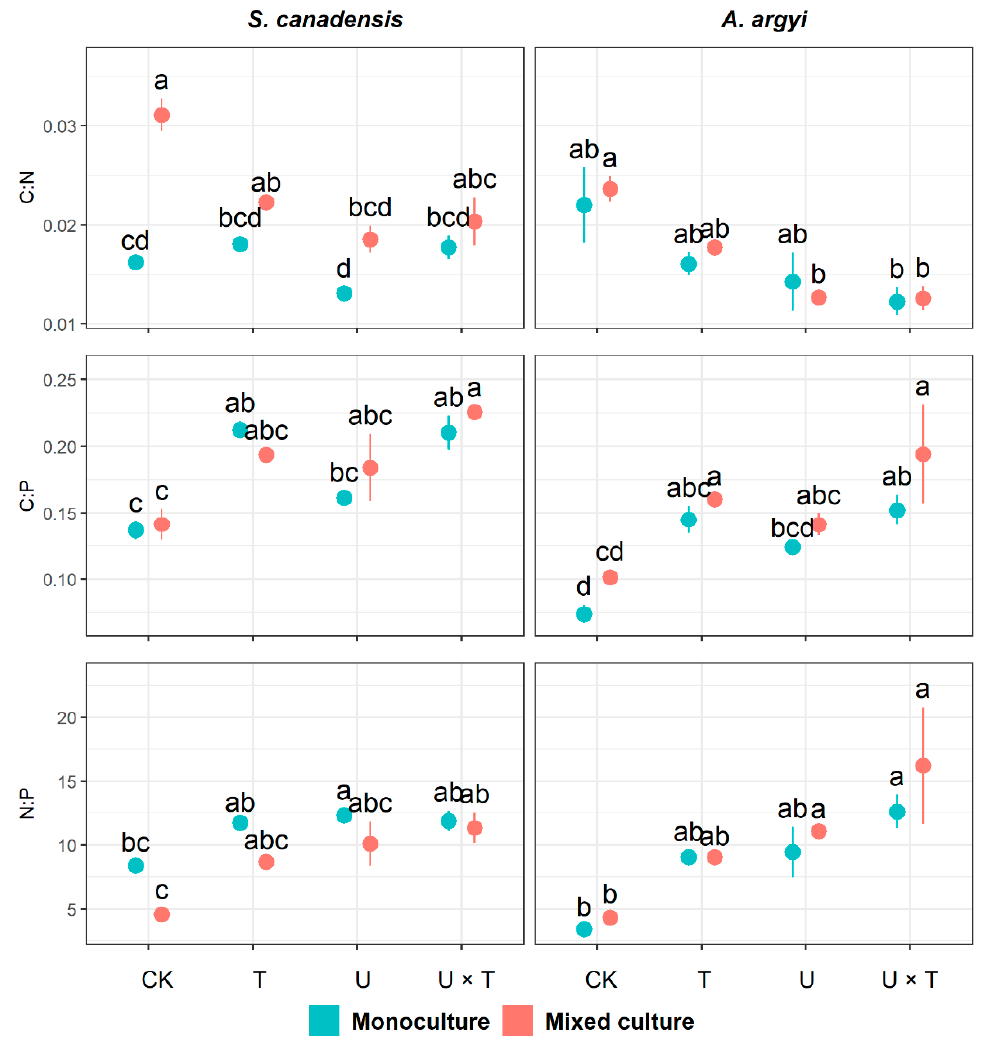
Figure 3. Effects of temperature and UV light on plant nutrient ratios in invasive Solidago canadensis and the co-occurring native species, Artemisia argyi, across plant communities (i.e., invasive species only, native species only and mixed community). Each plant community was grown under four different treatments: ambient temperature and ambient UV (control group, CK), warming and ambient UV (T), ambient temperature and high UV (U), and high UV and warming (U × T). The solid data points represent the arithmetic mean, and the bars indicate the standard error (±SE). Significant differences ( p < 0.05) among treatments are denoted by different letters above the data points. Table 3. Mixed effects analysis of temperature (T), UV light (U), and plant community (C) on plant nutrient ratios of invasive Solidago canadensis and native Artemisia argyi when grown in monoculture and together in a mixed community.